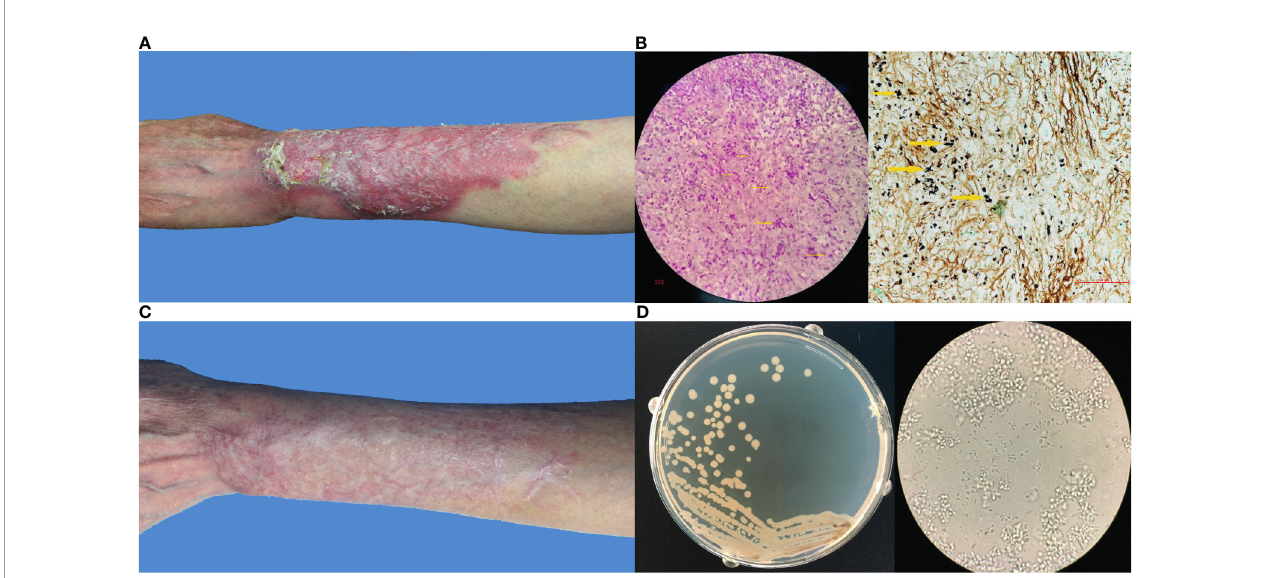
FIGURE 1 | (A) Clinical image of this patient before treatment; (B) Histopathological examination by Periodic acid – Schiff stain and Methenamine silver stain showing a type of infectious granuloma, abundant blastoconidia, and hyphae elements (yellow arrows indicated); (C) Clinical image of this patient after treatment; (D) Fungal culture showing yeast-like colonies and budding spores under